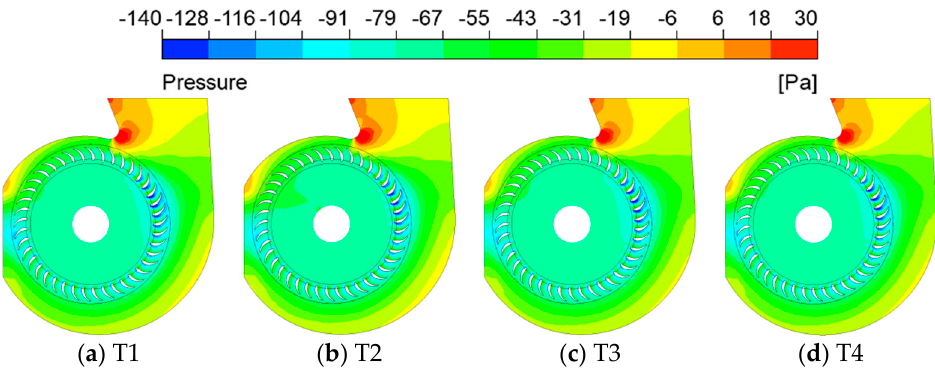
Figure 8. Distribution of static pressure on Z = 4 mm cross-section for the r = 4 mm model.